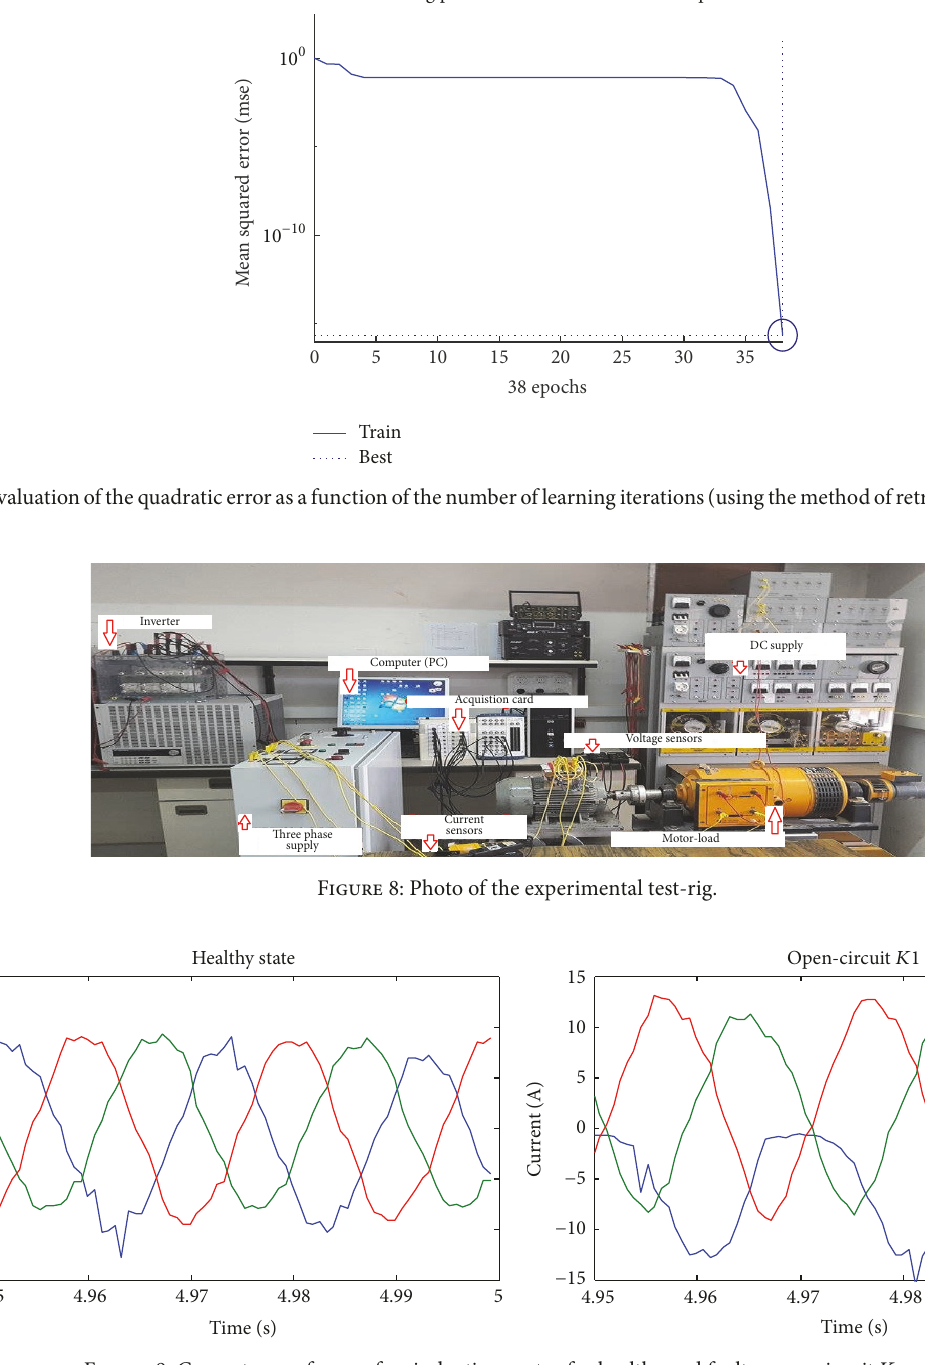
Figure 9: Currents waveforms of an induction motor for healthy and faulty open-circuit 𝐾 1